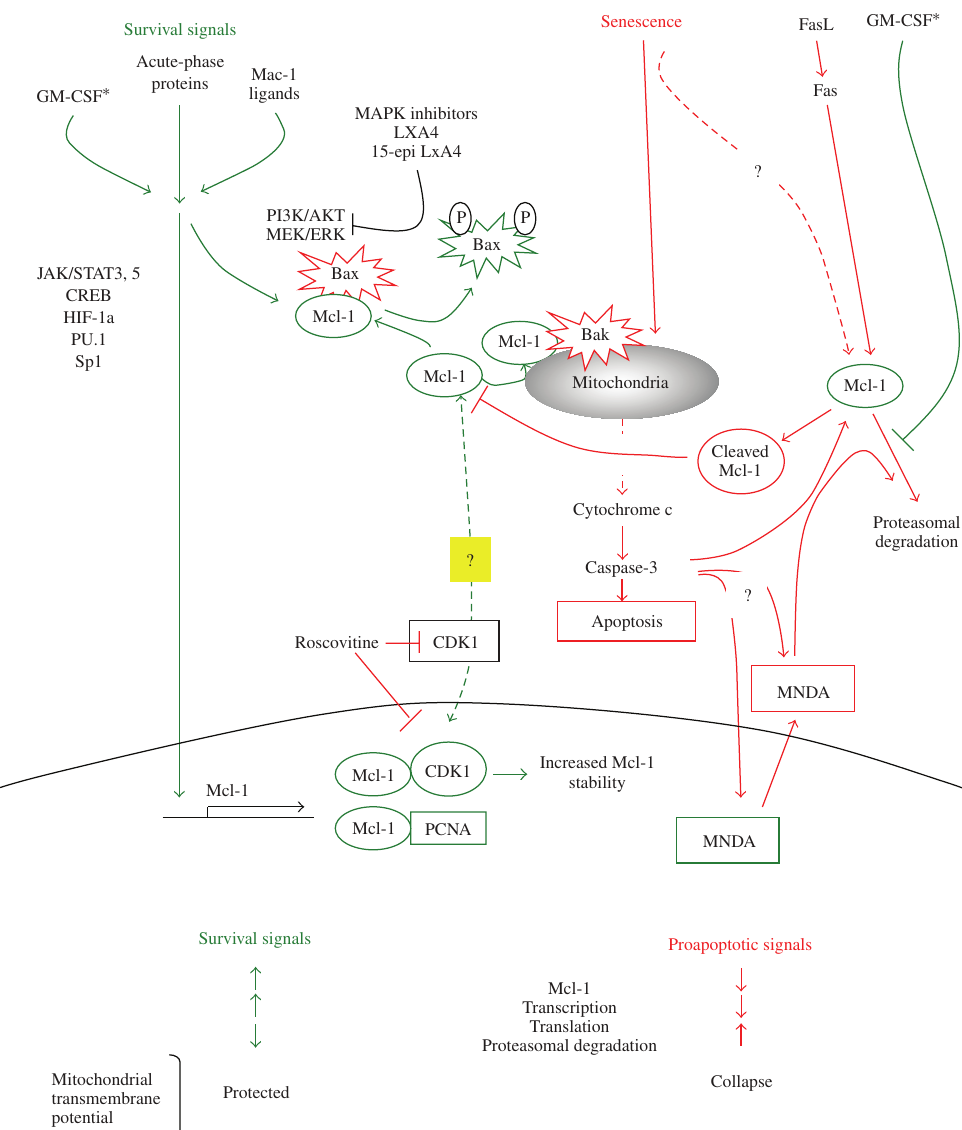
FIGURE 1: Mcl-1 integrates survival and proapoptosis cues in human neutrophils. Mcl-1 functions as a survival signal for human neutrophils by blocking the proapoptotic action of Bak (and/or Bim) at the outer mitochondrial membrane. In aging neutrophils, decreases in Mcl-1 level may precede initiation of the cell death program. At later stages, Mcl-1 is rapidly degraded by the proteasome and/or cleaved